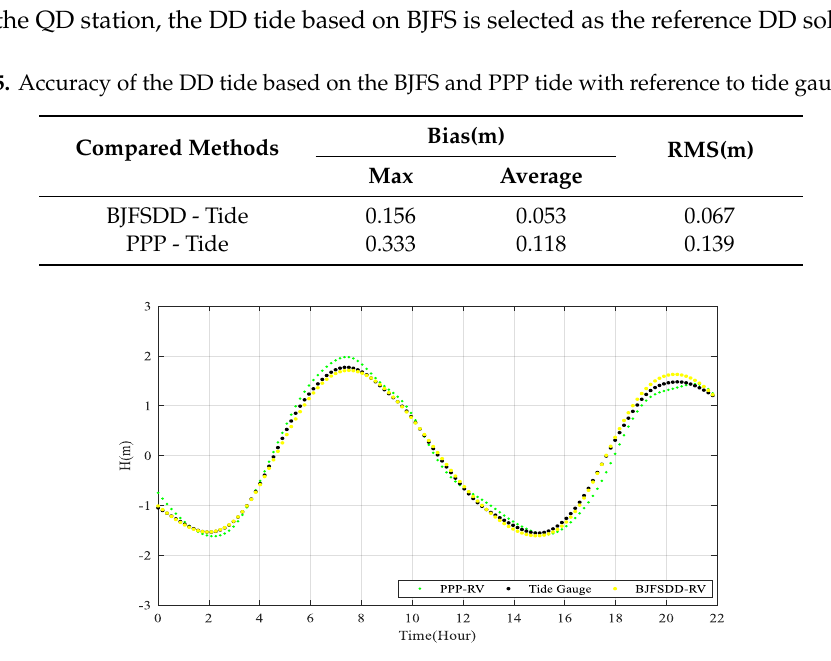
Figure 12. Comparison of the DD tide based on the BJFS and PPP tide with tide gauge data.